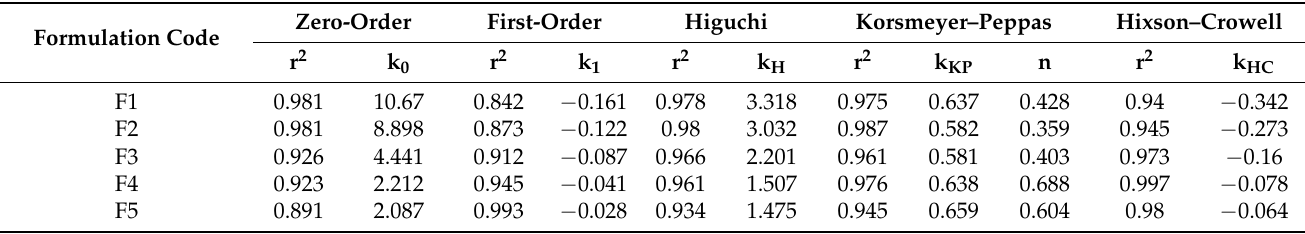
Table 3. In vitro dissolution data fitted to various